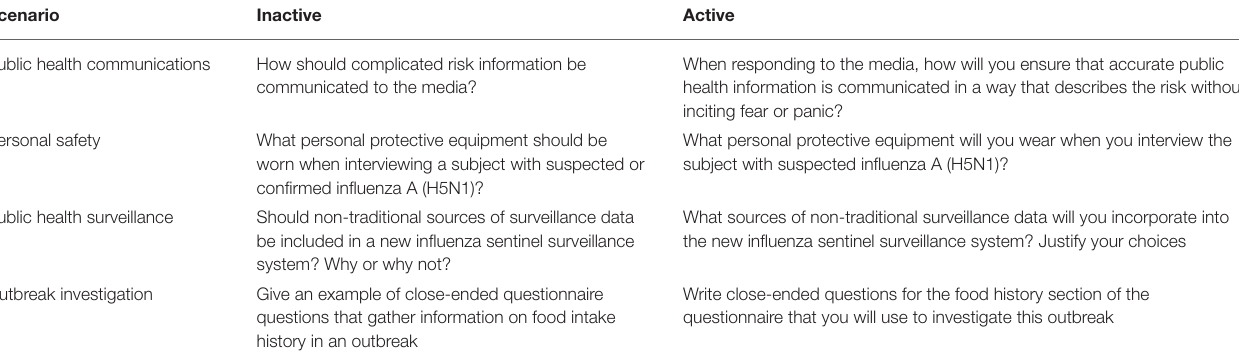
TABLE 4 | Comparison of scenarios with inactive vs. active questioning